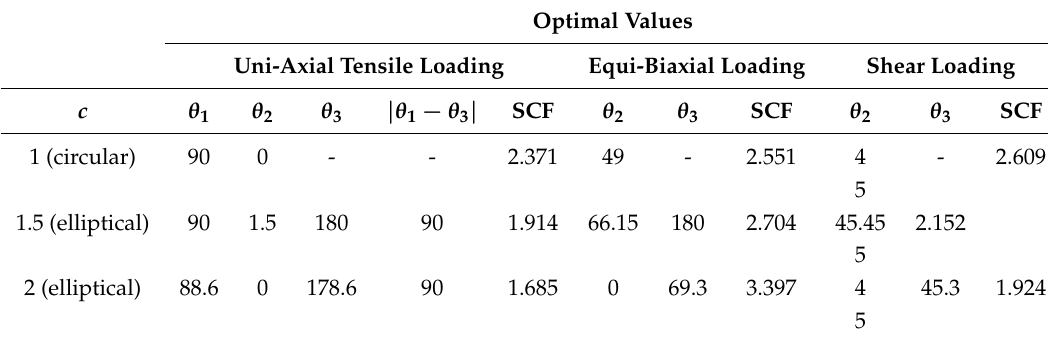
Table 7. Optimal values of design variables in different aspect ratios of cutout ( w = 0).